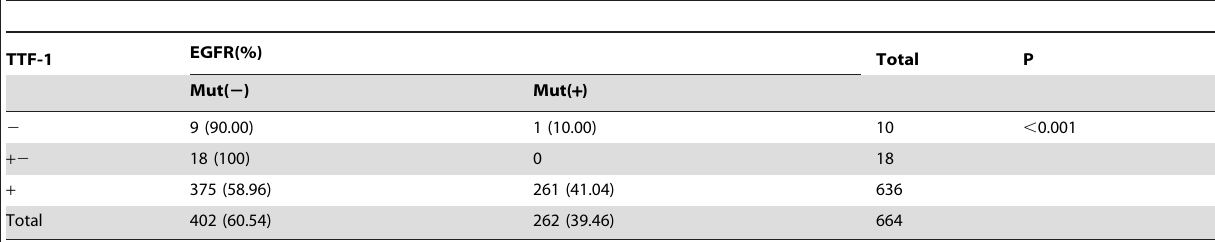
Table 3. The relationship between TTF-1 and EGFR mutation in lung adenocarcinomas.